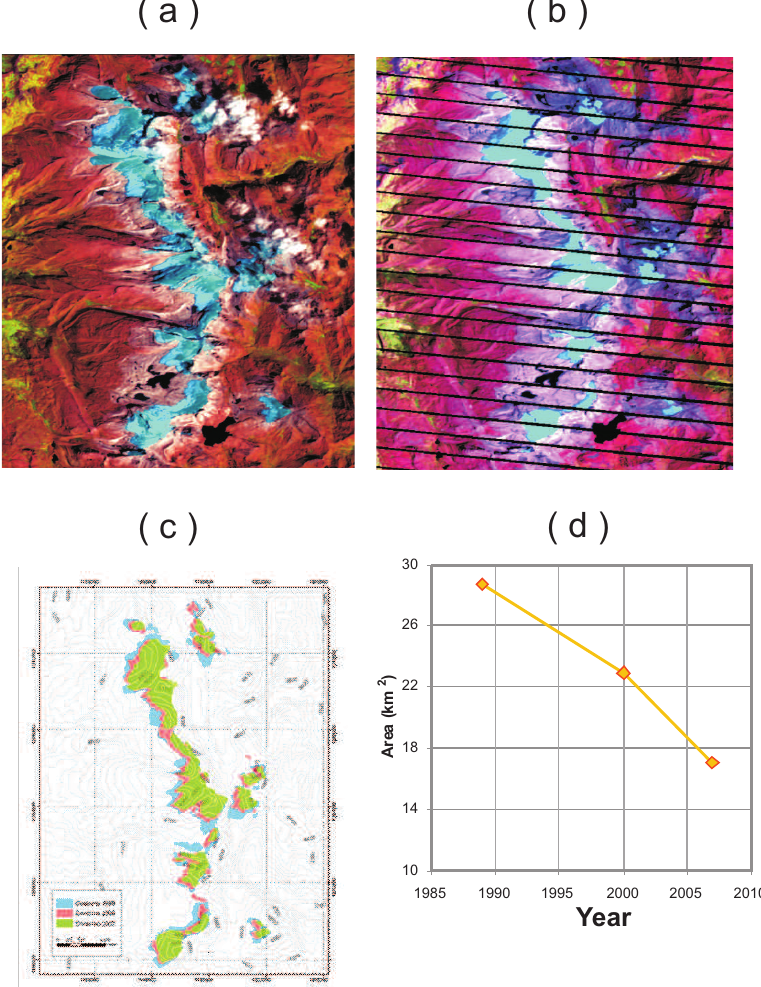
Fig. 6. Landsat images of the Sierra Nevada del Cocuy in (a) December 1987, and (b) January 2007. (c) Glacier countours in 1989 (blue), 2000 (pink), and 2007 (green). (d) Time evolution of glacier areal extent: 28.66 km 2 (1989), 22.9 km 2 (2000), and 17.00 km 2 (2007). 6. Nevado del Huila volcano. Estimates of glacierized 18